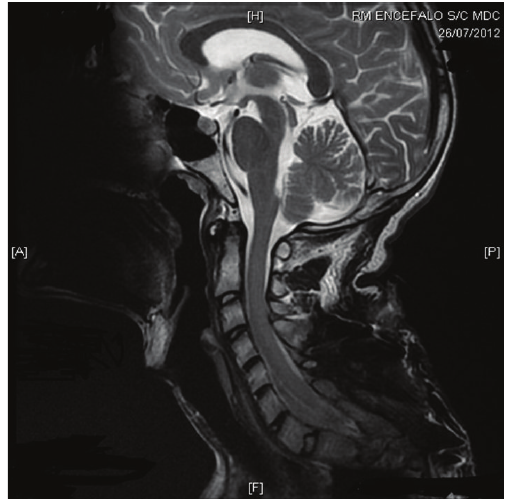
Figure 2: Cervical magnetic resonance imaging showing the pres- enceofafistuloustractandafluidpocketinthesubcutaneoustissues overlying C4.